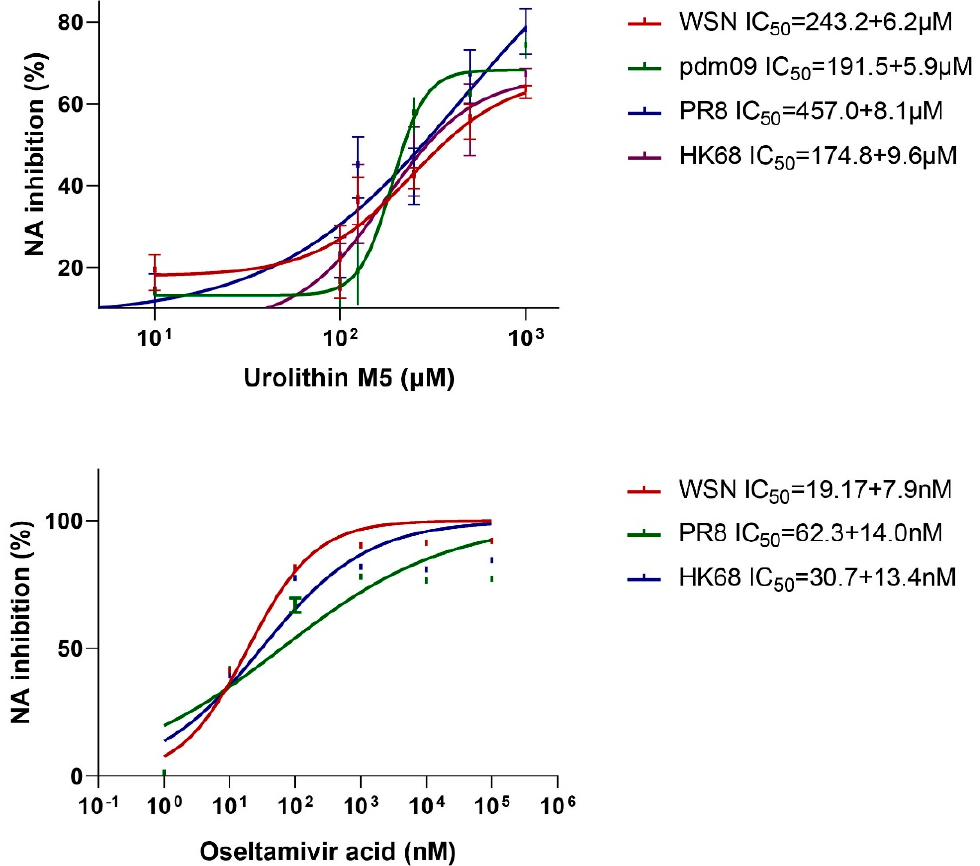
Figure 2. Assay of urolithin M5 on NA inhibition. Oseltamivir acid was used as positive control with an IC 50 of 19.17 nM (WSN), 62.3 nM (PR8) and 30.7 nM (HK68). The experiments were repeated three times for confirmation.